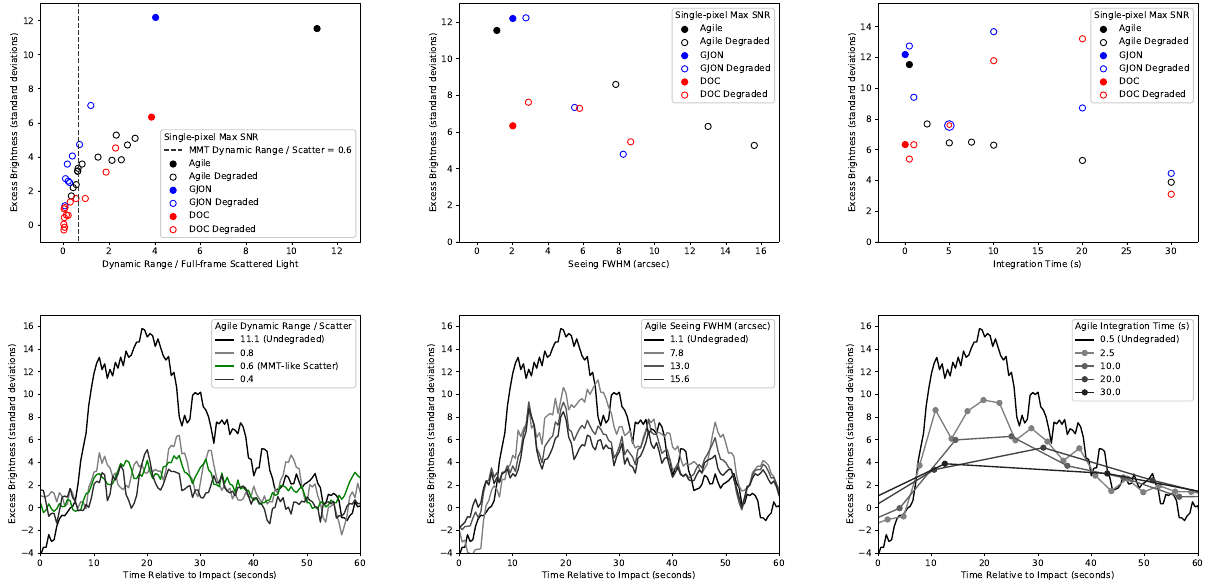
Figure 8. Maximum retrieved SNR over 15 to 33 s after impact from degraded data at the maximum SNR pixel (see Figure 4). From left to right, these are results for additional scattered light, worsened atmospheric seeing, and longer exposures. The bottom row shows lightcurves for selected data. The lightcurve for an MMT-like amount of scattered light does not fully characterize MMT because it does not take other factors into account (e.g., the fact that the dynamic range of MMT data was smaller than that of Agile